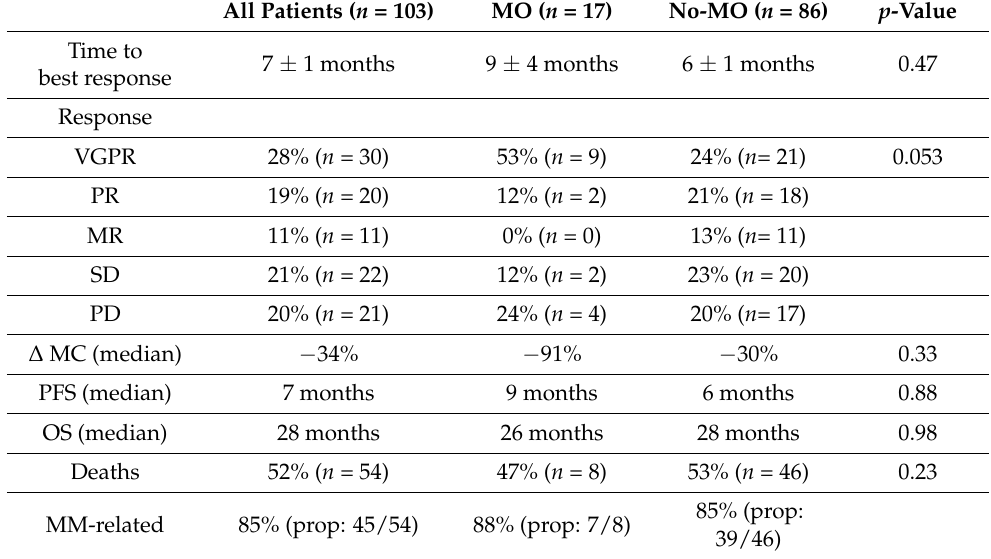
Table 2. Outcome data in the whole population and subgroups. MO: molecularly oriented. All Patients ( n = 103)